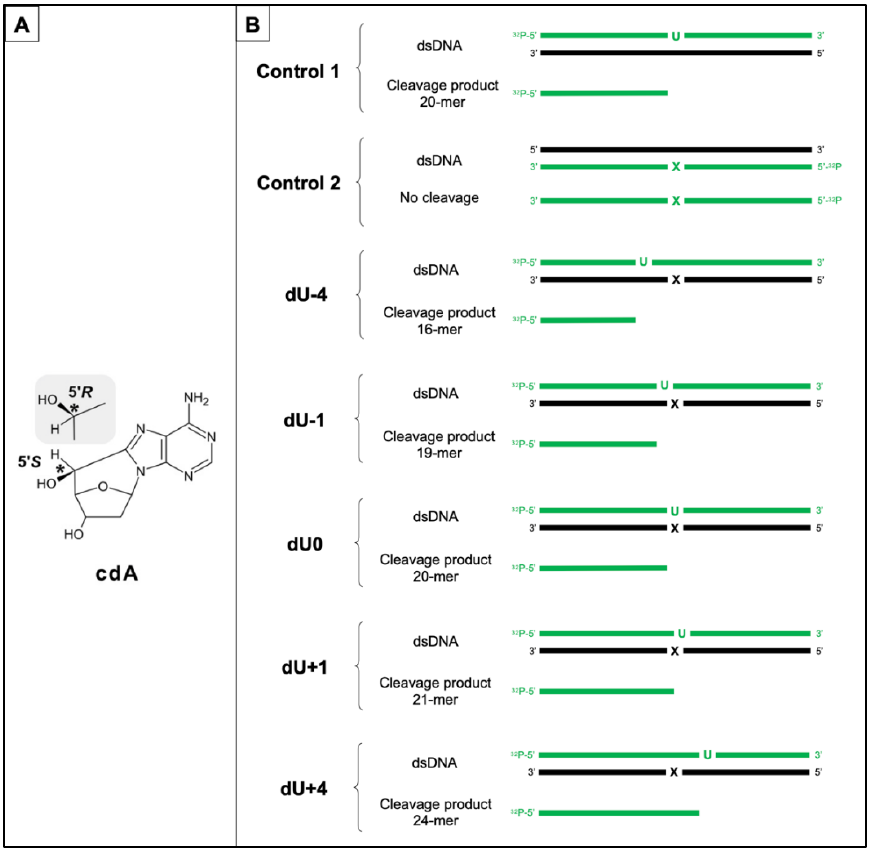
Figure 2. ( A ) The chemical structure of 5 (cid:48) ,8-cyclo-2 (cid:48) -deoxyadenosine (cdA) with its 5 (cid:48) S and 5 (cid:48) R diastereomers. ( B ) The list of investigated double-stranded oligonucleotides. U—the position of an AP site within the strand which was obtained from 2 (cid:48) -deoxyuridine (dU) after treatment with uracil DNA-glycosylase (UDG); X—the position of the cdA within the strand; 32 P marks the 5 (cid:48) -end of the strand radiolabeled with [ γ - 32 P]ATP; green color—a radiolabeled strand of ds-oligonucleotides (40 bp) and corresponding cleavage product (observed on autoradiograms; its length depends on the AP site location); negative numbers—ds-oligonucleotides with clustered DNA lesions placed on two strands where AP site is located 1–4 bp in 3 (cid:48) -end direction; positive numbers—ds-oligonucleotides with clustered DNA lesions placed on two strands where AP site is located 1–4 bp in 5 (cid:48) -end